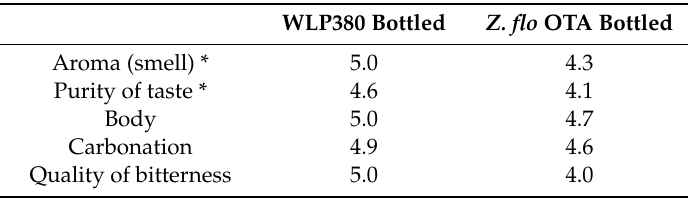
Table 4. Results according to the Deutsche Landwirtschafts-Gesellschaft (DLG) scheme, in which the beer is judged by its aroma, taste, carbonation, body and bitterness in a range of 1–5, 1 being the lowest value (negative) and 5 being the highest value (positive); arithmetic mean of results of 10